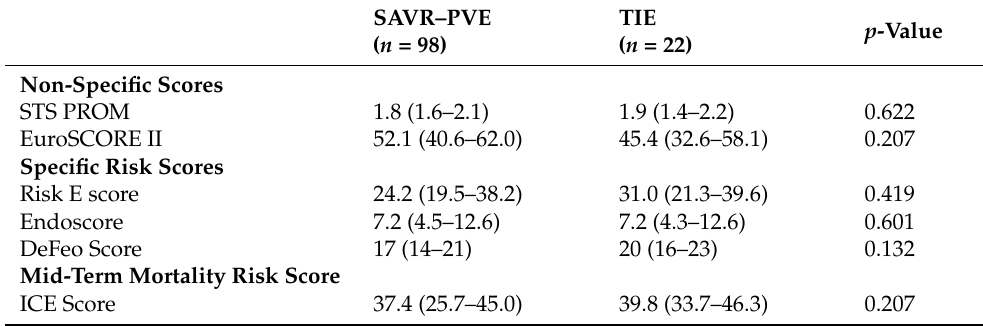
Table 2. Endocarditis-specific and -non-specific risk scores.